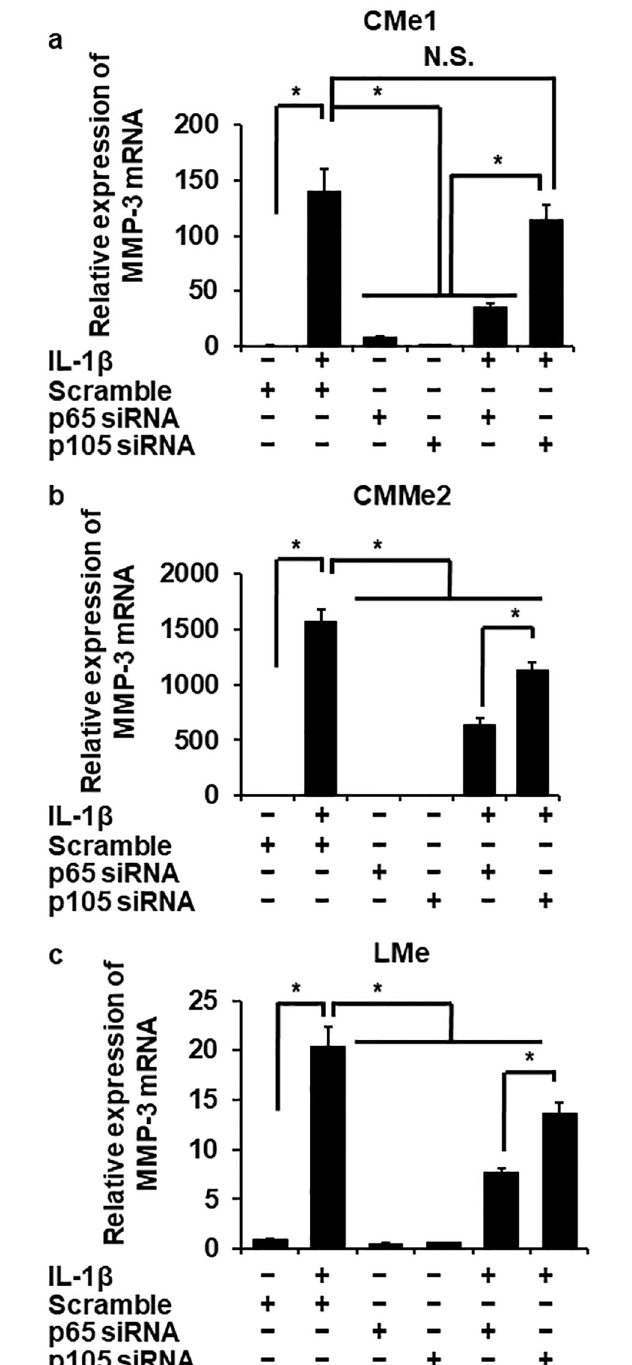
Fig 5. Attenuation of IL-1 β -induced MMP-3 mRNA expression in other sets of melanoma cells transfected with p65/RelA siRNA, but not with p105 siRNA. Melanoma cells (a, CMe1; b, eCMMe2; c, LMe) transfected with p65/ RelA, p105, or scrambled siRNAs following the stimulation of IL-1 β (100 pM) for 24 h. Relative expression of MMP-3 mRNA was evaluated. TBP was used as a reference. The attenuation of MMP-3 expression was observed in p65/RelA- depleted cells but not in the cells transfected with p105 siRNA or scrambled siRNA. The results are represented as mean ± standard error (SE) of biological triplicates. � P < 0.05.